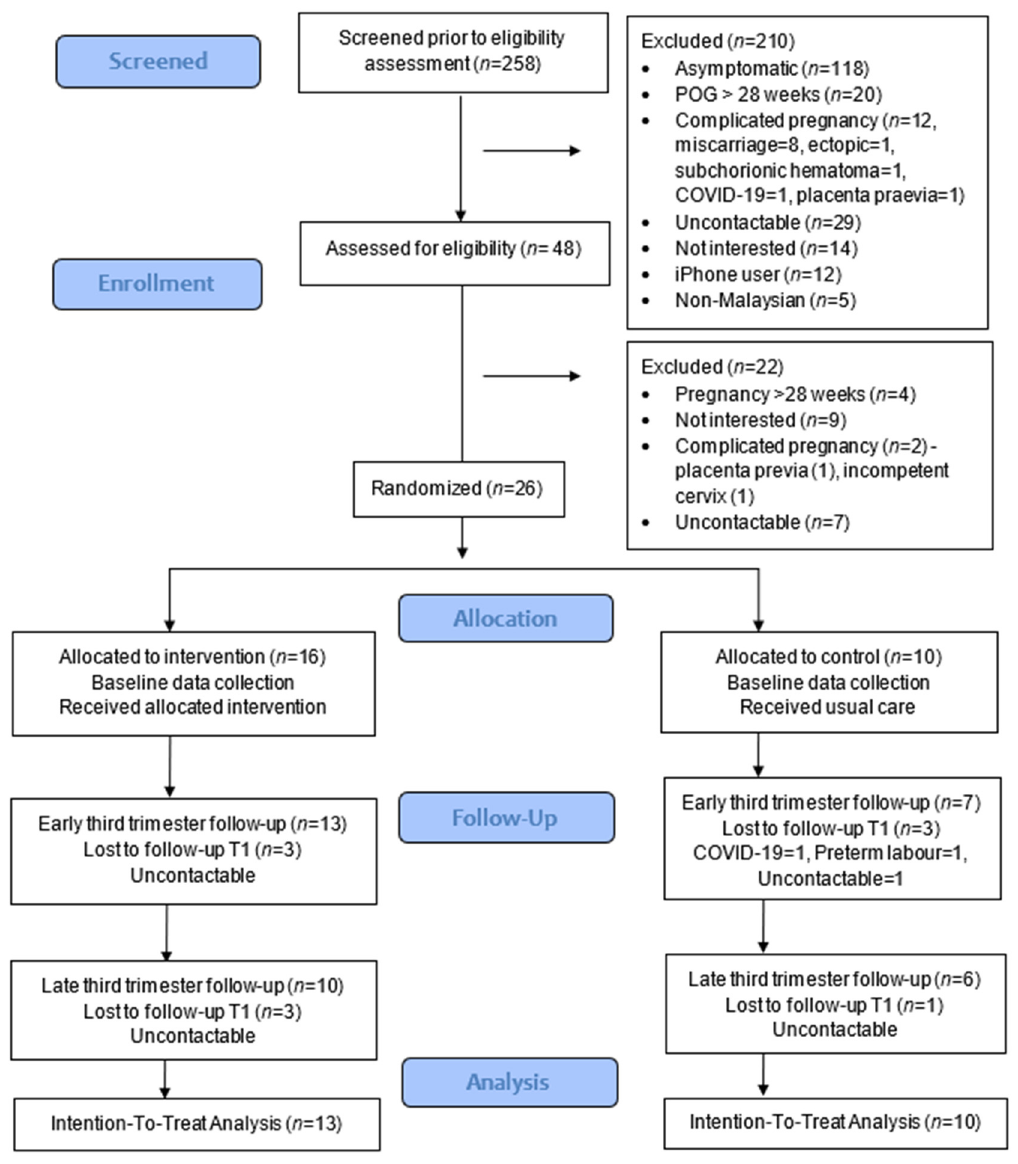
Figure 1. CONSORT study flowchart.